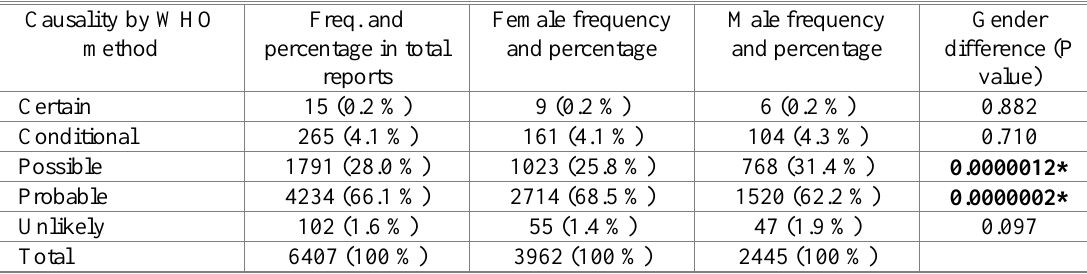
Table 6. Causality assessment of